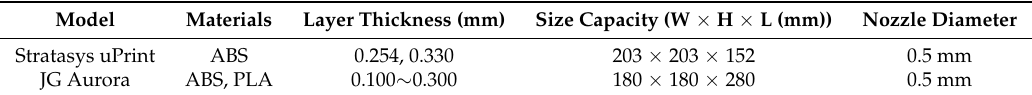
Table 1. Parameters of FDM machines.